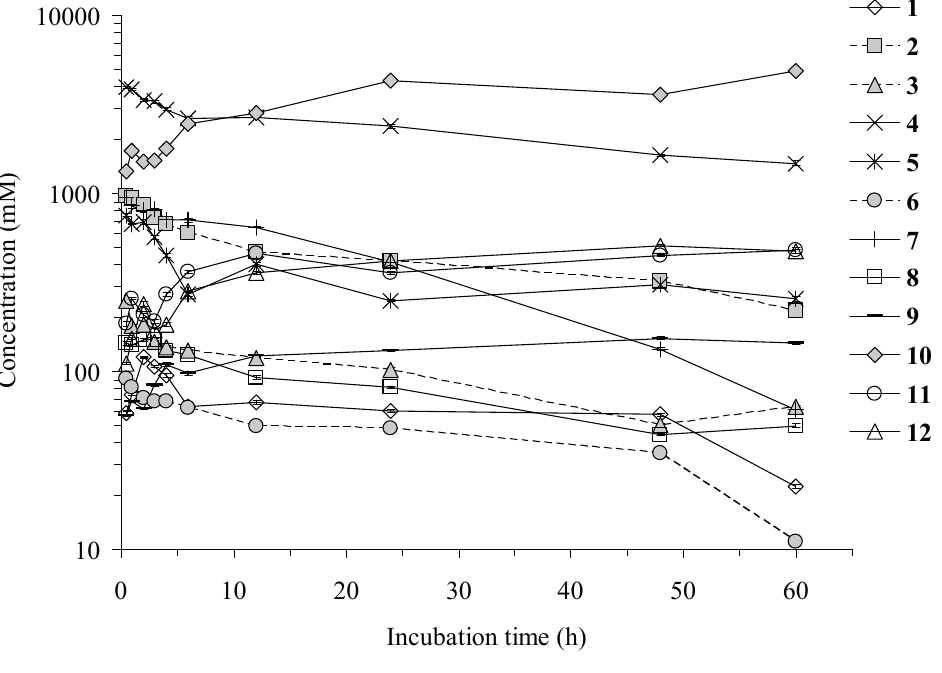
Figure 3. Time course of the twelve constituents of TMF by HIF ( n = 6, mean ±